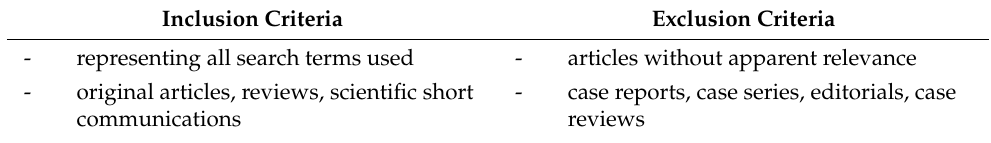
Table 1. Inclusion and exclusion criteria.